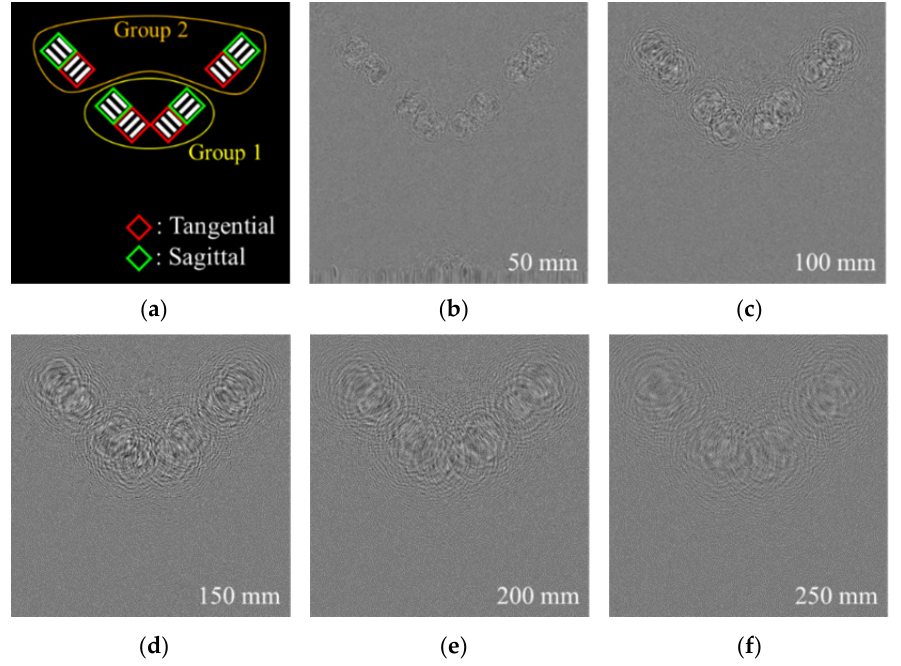
Figure 8. Fresnel holograms for experiments. ( a ) The target object image and Fresnel holograms of the object positioned at ( b ) 50, ( c ) 100, ( d ) 150, ( e ) 200, and ( f ) 250 mm from the hologram plane.